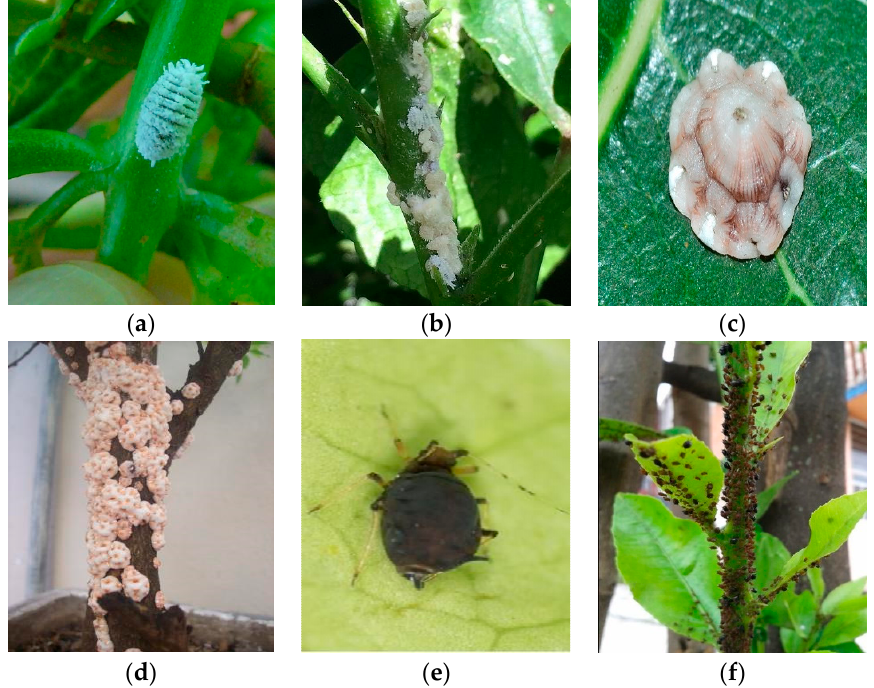
Figure 2. Examples of small size citrus pests: ( a ), ( c ), and ( e ) are the images of their individuals, ( b ), ( d ), and ( f ) are those of their